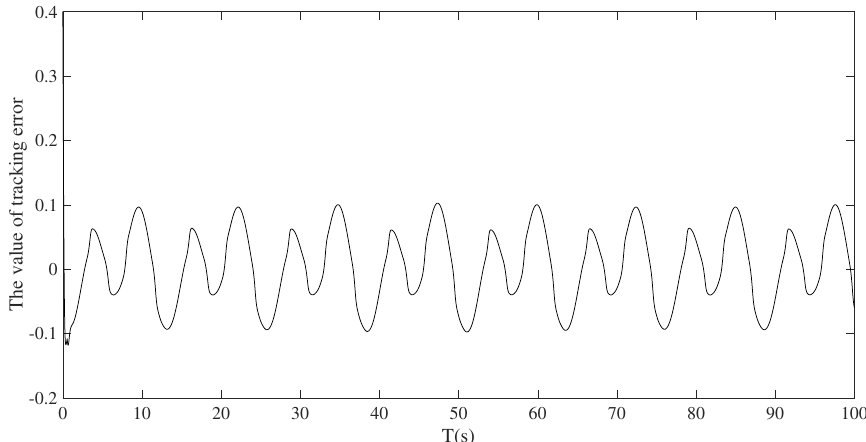
Figure 15. Tracking error curve in the case of a chemical